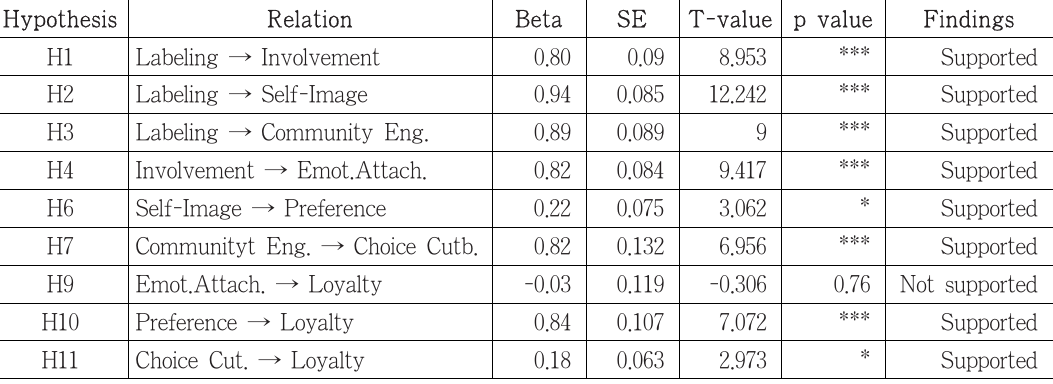
<Table 4> Structural model assessment of direct relationship